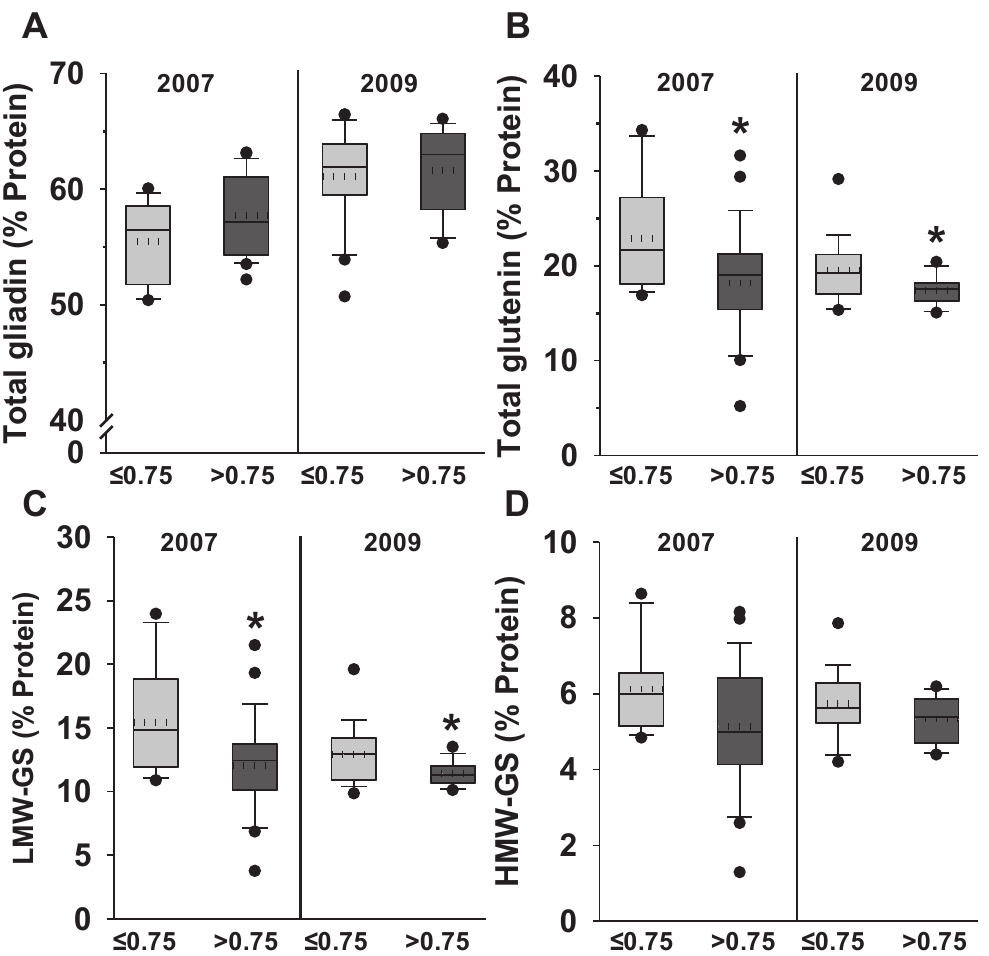
Fig. 4: Total gliadin (A), total glutenin (B), LMW-GS (C), and HMW-GS (D) content of flour Type 550 samples in 2007 and 2009 grouped into fulfilling (≤0.75) and exceeding (>0.75) EU maximum level of DON (mg kg -1 ) for flour. Significant difference between groups within year is indicated through * (p<0.001). Box plots show 25-75% percentile, median (solid line), and mean (dotted